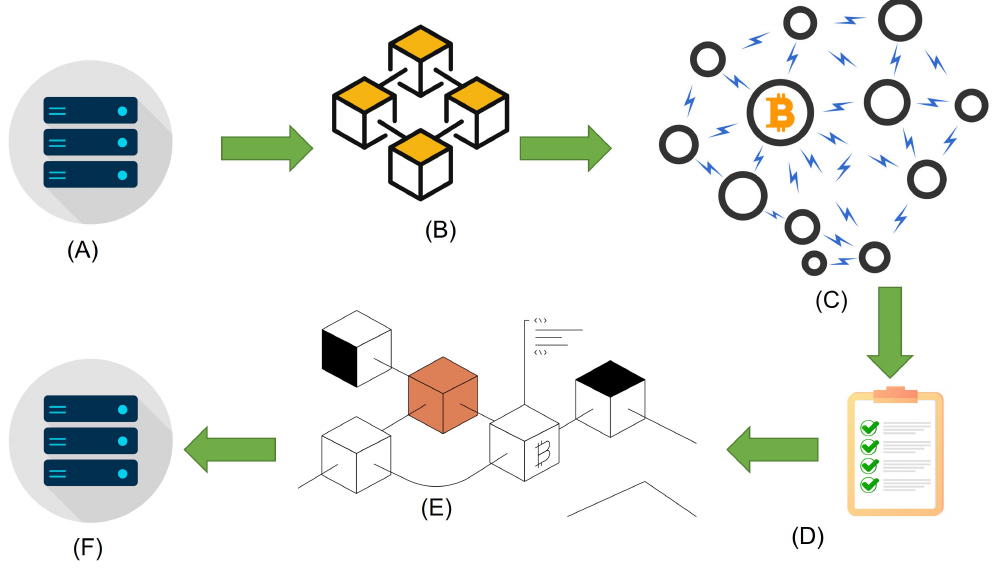
Figure 2. Flowchart of a blockchain network for transaction processing: ( A ) the transaction is initiated by the consumer, ( B ) the network represents the transaction as a block, ( C ) the verification of the block is broadcast to every node in the network, ( D ) validation of transactions is conducted by nodes, ( E ) the resulting block may then be added to the chain of blocks that serve as a transparent transaction ledger, ( F ) the intended consumer receives the